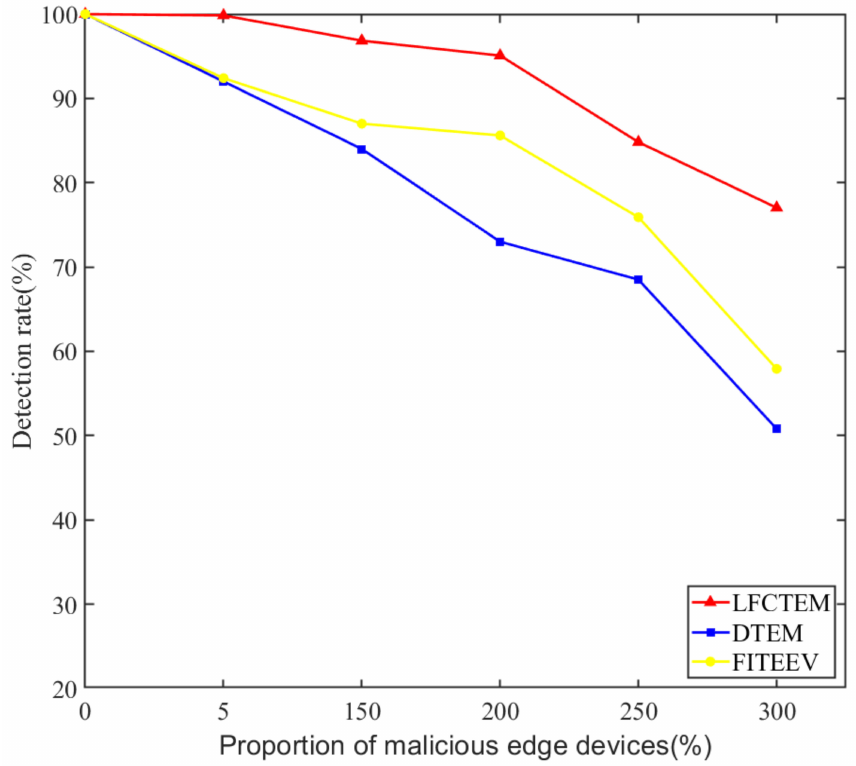
Figure 9. Comparison of detection rates of malicious edge devices by LFCTEM, DTEM and